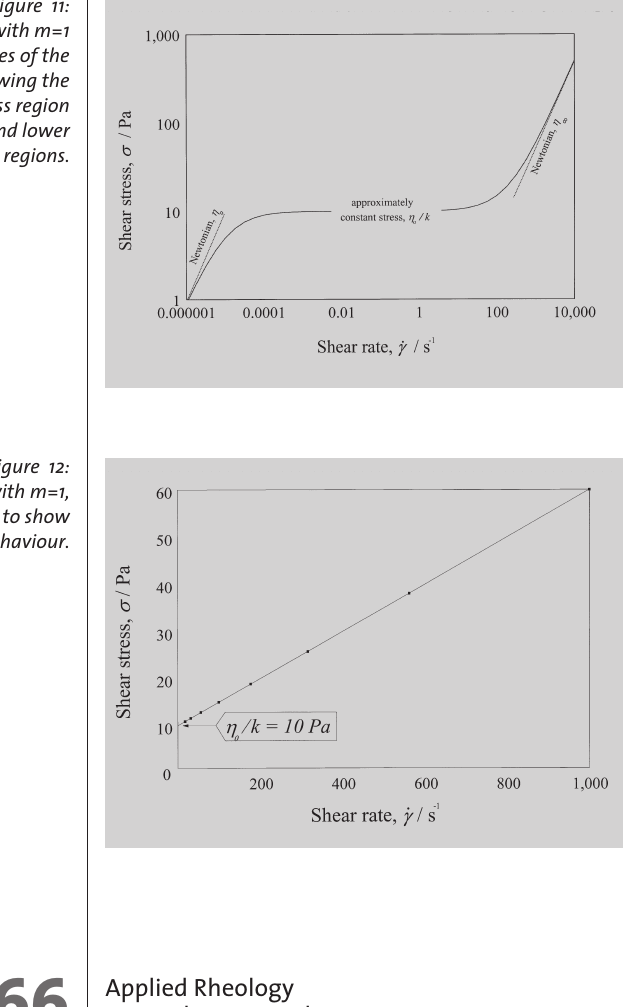
Figure 12: The Cross model with m=1, plotted linearly to show Bingham-type